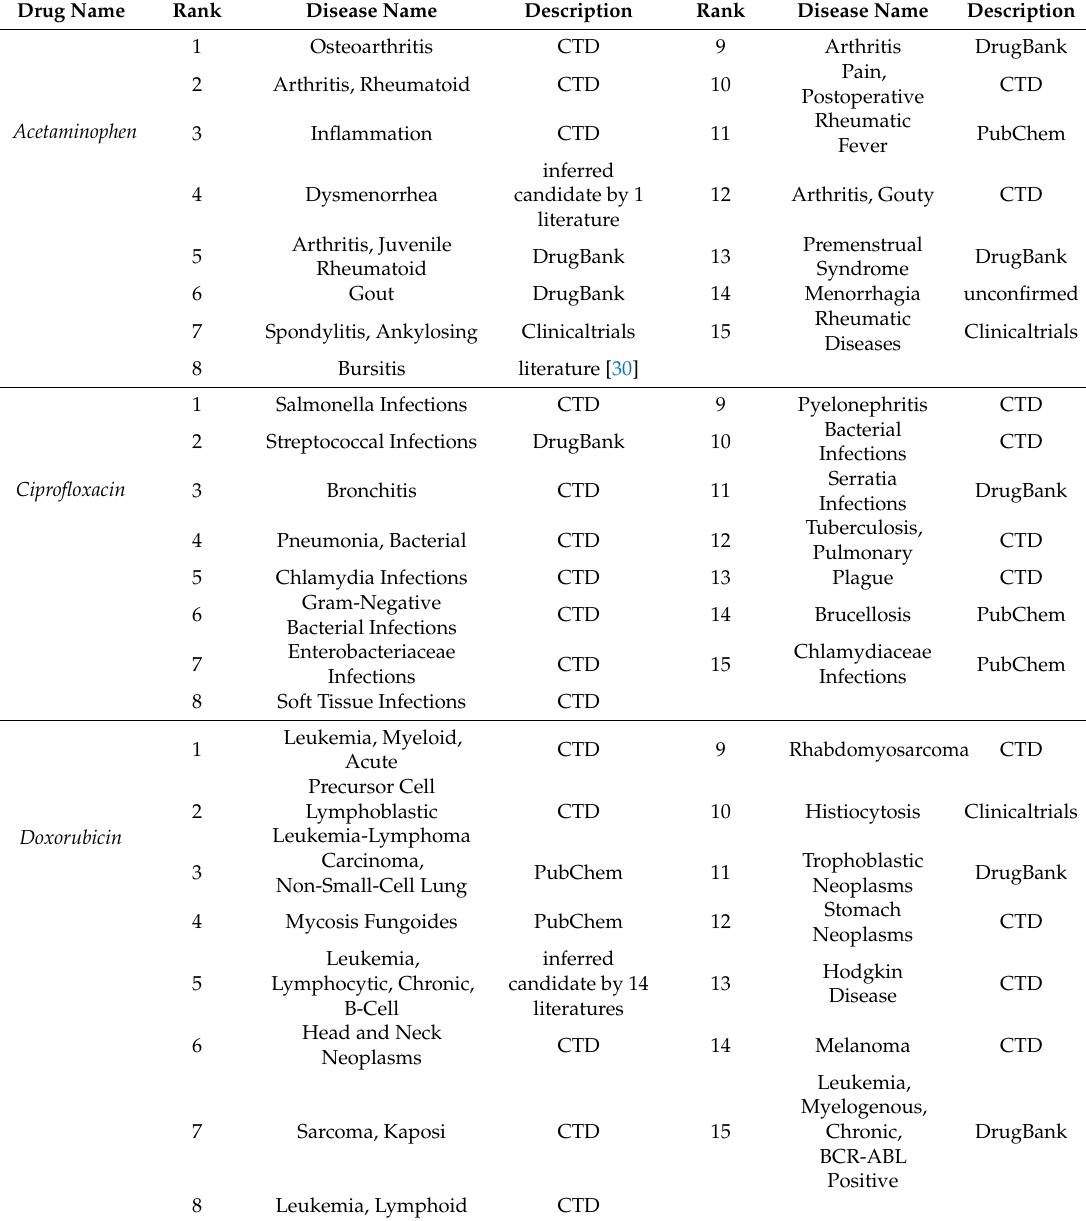
Table 4. The top 15 related candidate diseases for acetaminophen, ciprofloxacin, doxorubicin, hydrocortisone, and